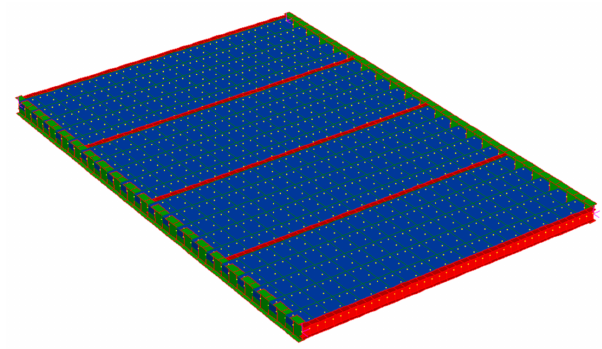
Figure 4. Dimetric View of Reference Model in